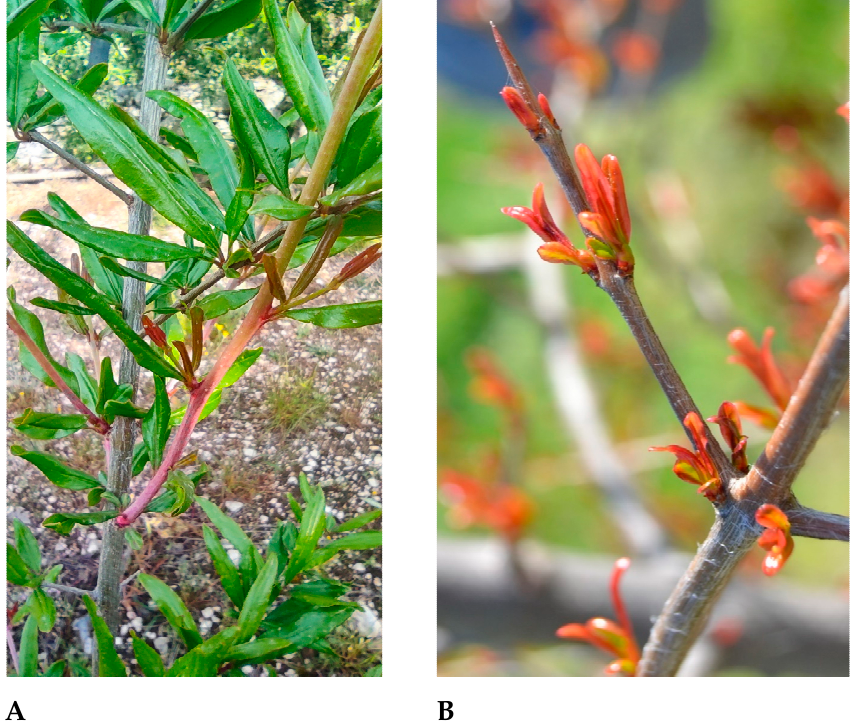
Figure 1. A vegetative bursting bud with developing growing secondary shoots ( A ) and a lignified secondary shoot with a terminal thorn and bursting buds ( B ) in ‘Comune S. Giorgio’.